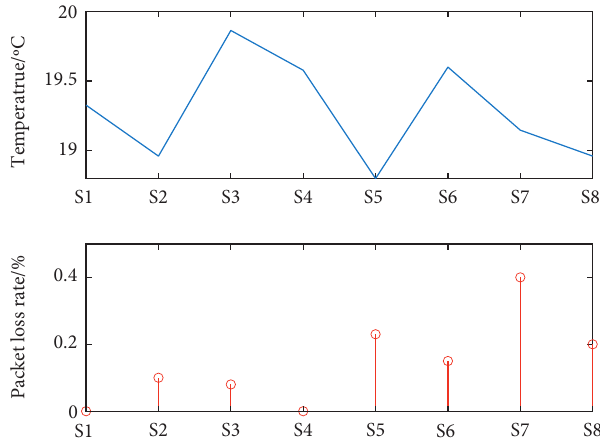
Figure 20: Packet loss rate and temperature of wireless temperature sensors at S1–S8